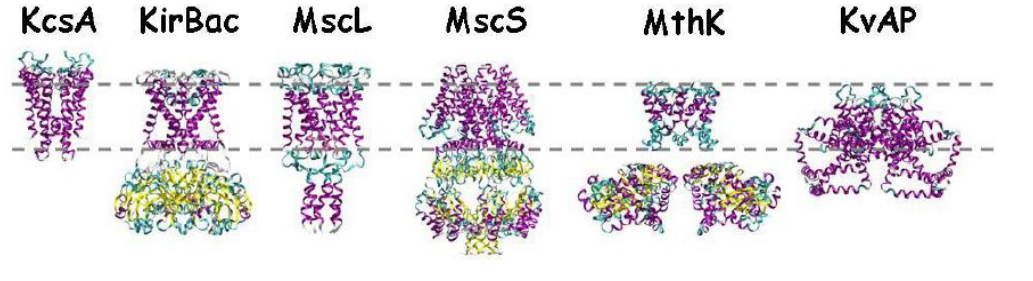
Fig. 2 Schematic diagrams of the folds of several ion channels represented as ribbons: KcsA, KirBac1.1, MscL, MscS, MthK, and KvAP. The horizontal lines show the approx- imate location of the bilayer with the intracellular domains at the bottom. The diagram was generated using VMD